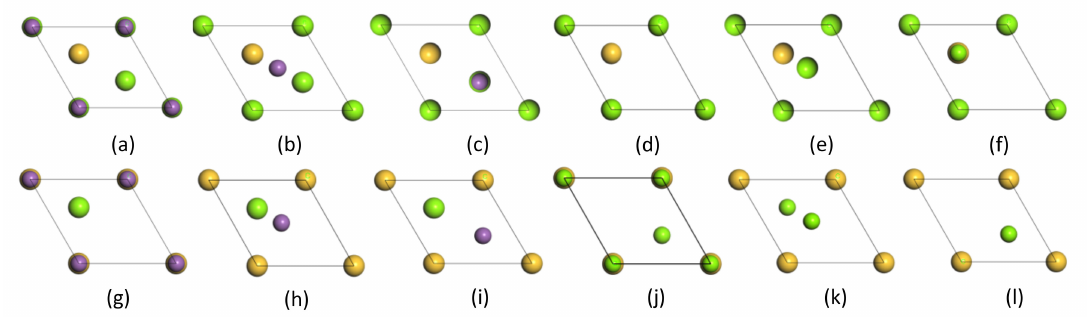
Figure 5. Top views of 12 di ff erent Mg 2 Si (111) / Mg 3 Sb 2 (0001) interface models: ( a – c ) Top, Bridge, and Hollow sites of Mg-terminated Mg 2 Si (111) and Sb-terminated Mg 3 Sb 2 (0001), ( d – f ) Top, Bridge, and Hollow sites of Mg-terminated Mg 2 Si (111) and Mg-terminated Mg 3 Sb 2 (0001), ( g – i ) Top, Bridge, and Hollow sites of Si-terminated Mg 2 Si (111) and Sb-terminated Mg 3 Sb 2 (0001), and ( j – l ) Top, Bridge, and Hollow sites of Si-terminated Mg 2 Si (111) and Mg-terminated Mg 3 Sb 2 (0001).